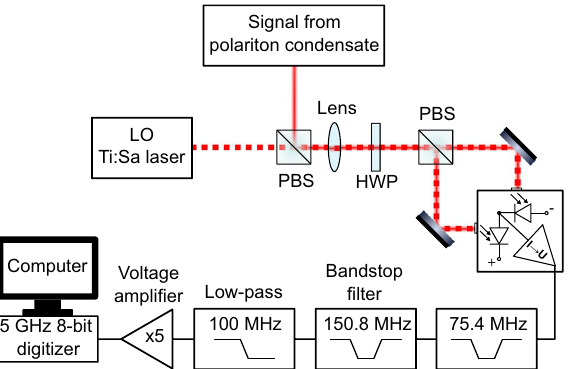
Figure 1. Schematic of the homodyne detection setup. LO: local oscillator; PBS: polarizing beam splitter; HWP: half-wave